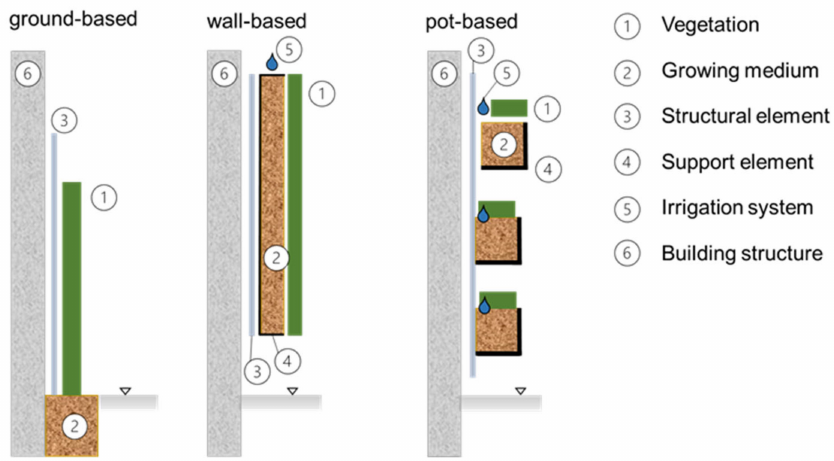
Figure 3. General structure of vertical greenery